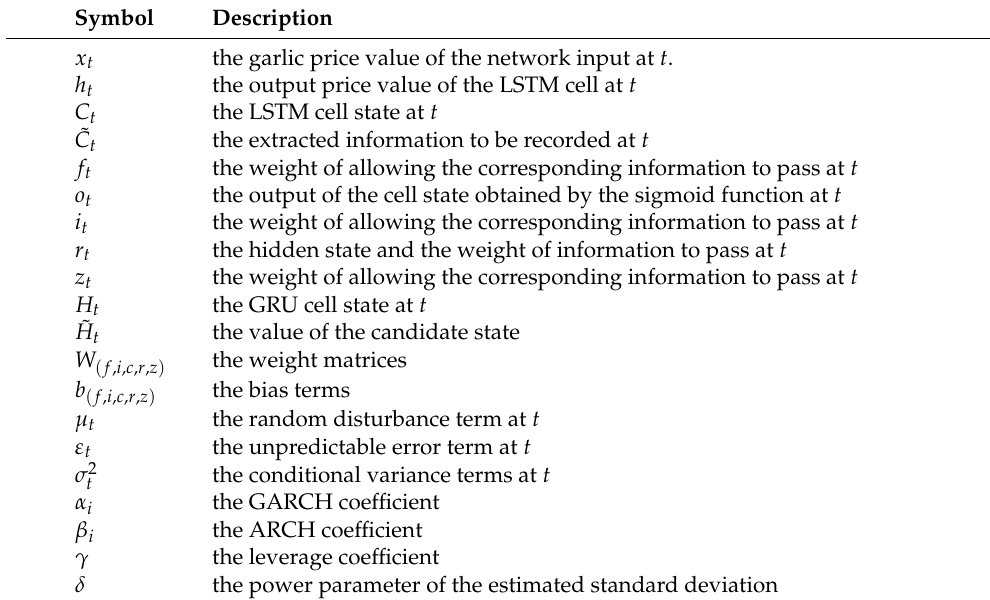
Table 2. List of symbols and